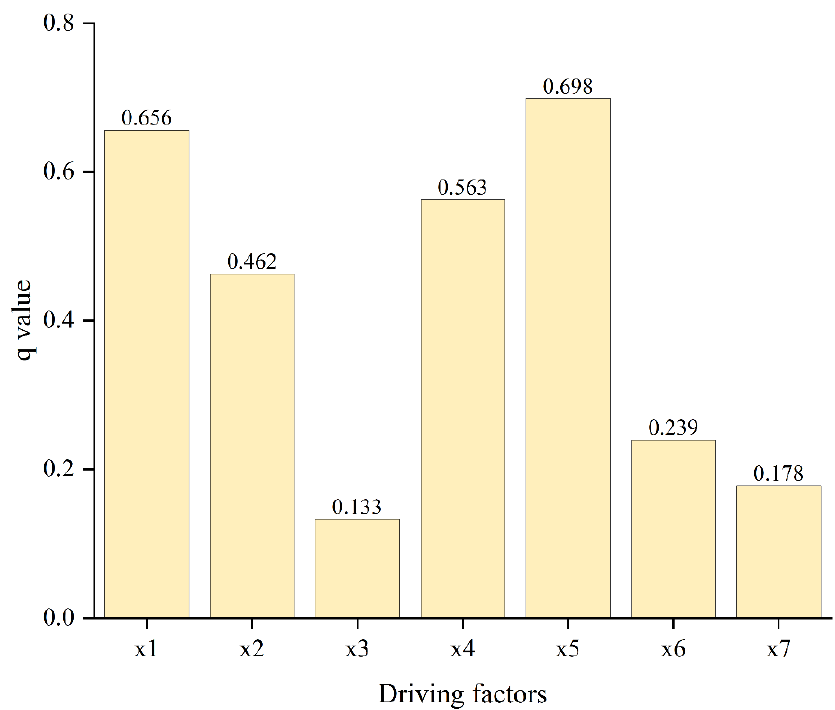
Figure 5. Driving factors contribution rate.